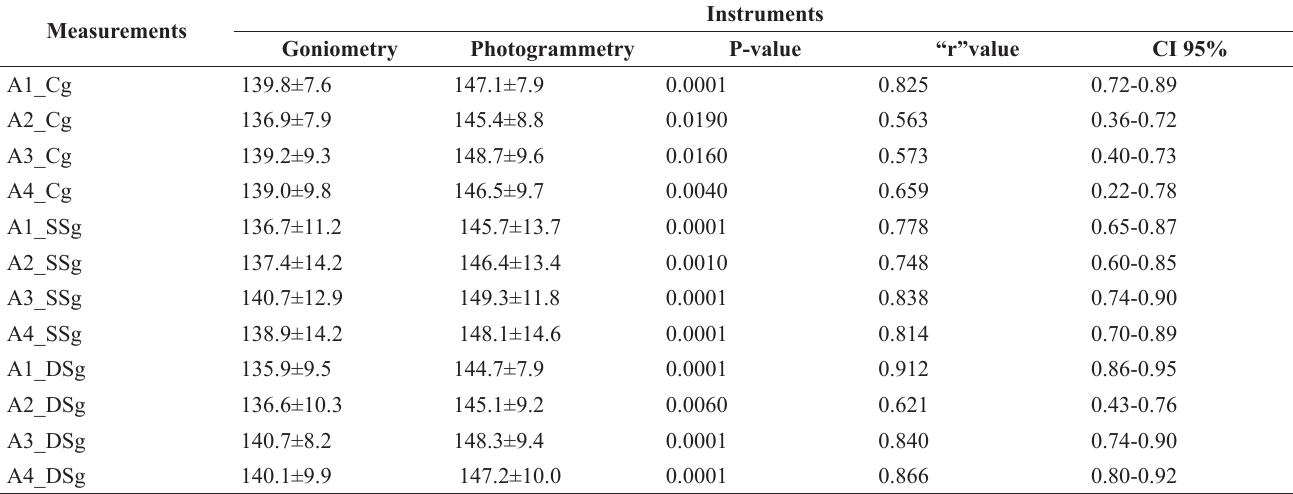
Table 3- Measurements of correlation inter-instruments (goniometry×photogrammetry) of active knee extension movement